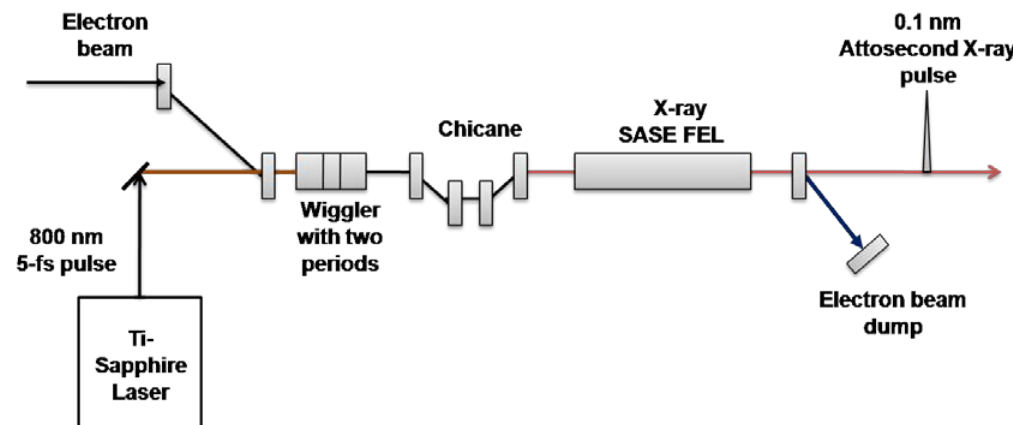
Figure 5. (Color online). ESASE scheme for attosecond pulse